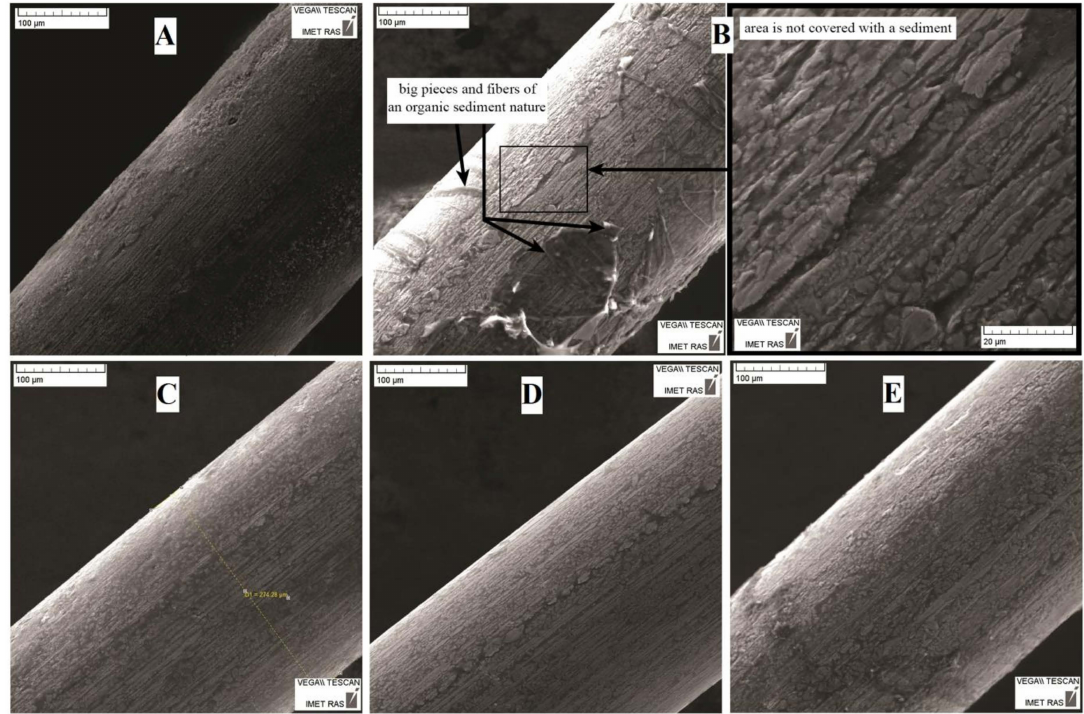
Figure 5. SEM images of the as-received NiTi sample surface after two years of immersion in various solutions: ( A ) bu ff er at pH 3.56 (Solution 2; Table 1); ( B ) bu ff er at pH 4.01 (Solution 3, Table 1);